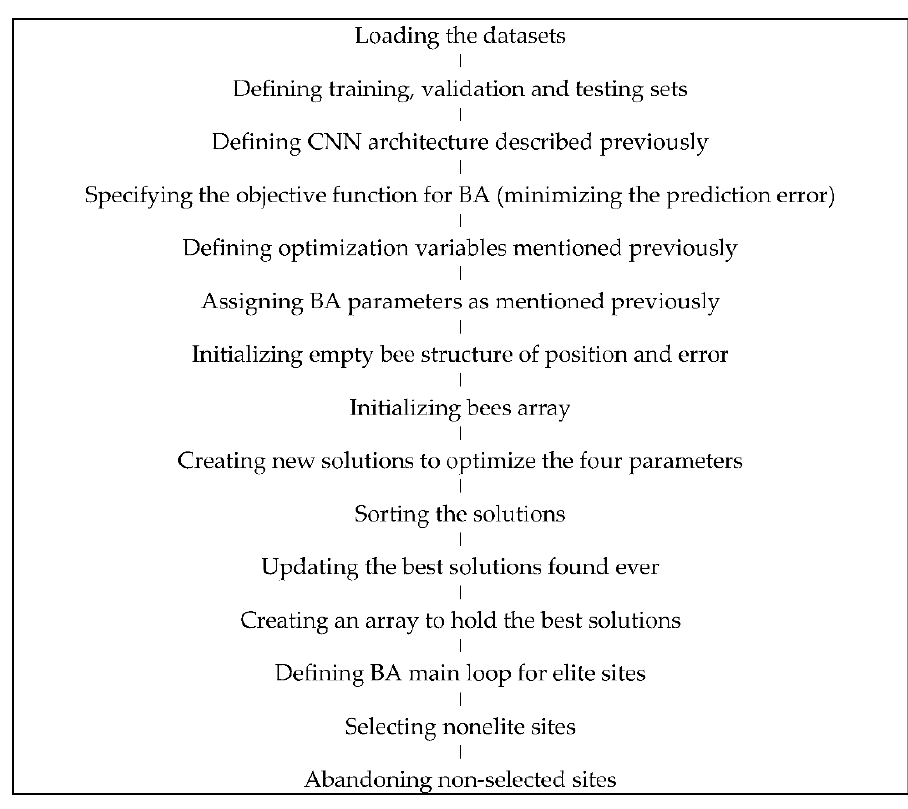
Figure 26. The pseudo code for BA-RCNN.